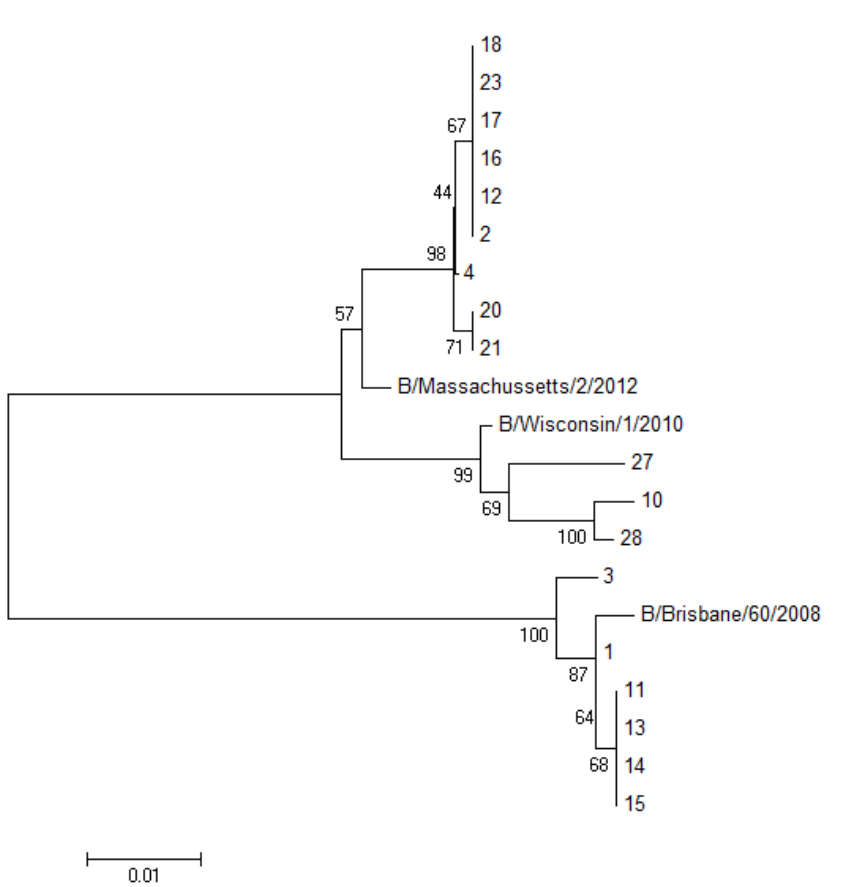
Figure 2. Phylogenetic tree of the HA1 portion from the HA gene of 18 sequenced samples analyzed with the neighbor joining algorithm. (The number of sequences in the tree corresponds to the patient’s number reported in Table